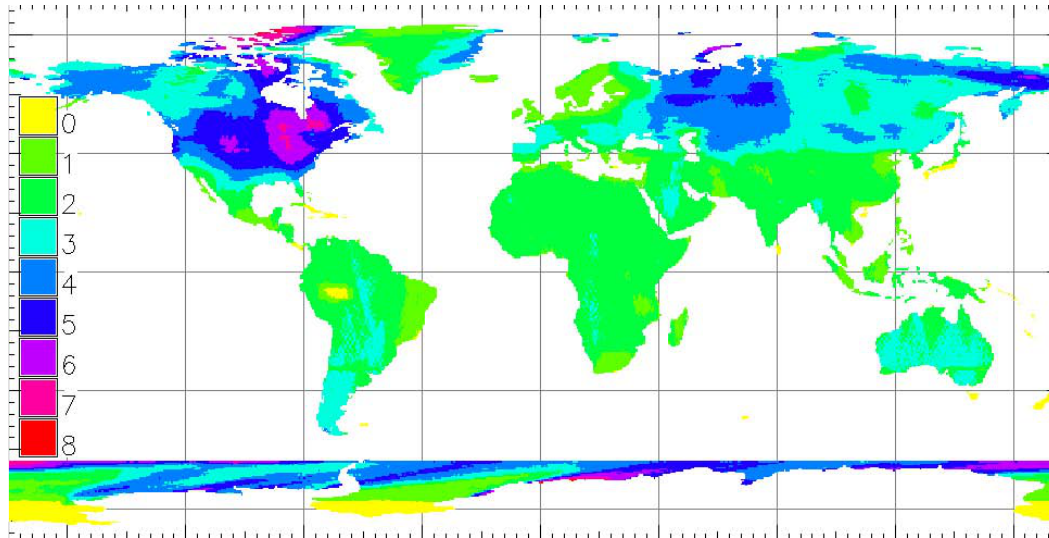
Fig. 21. Average frequency of terrestrial coverage per week by GM data between September 2009 and May